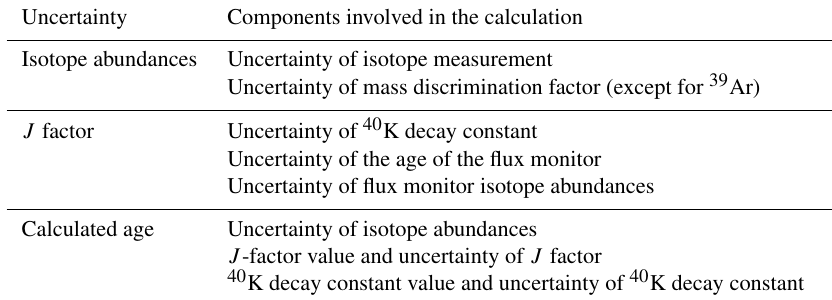
Table B3. Calculation parameters for